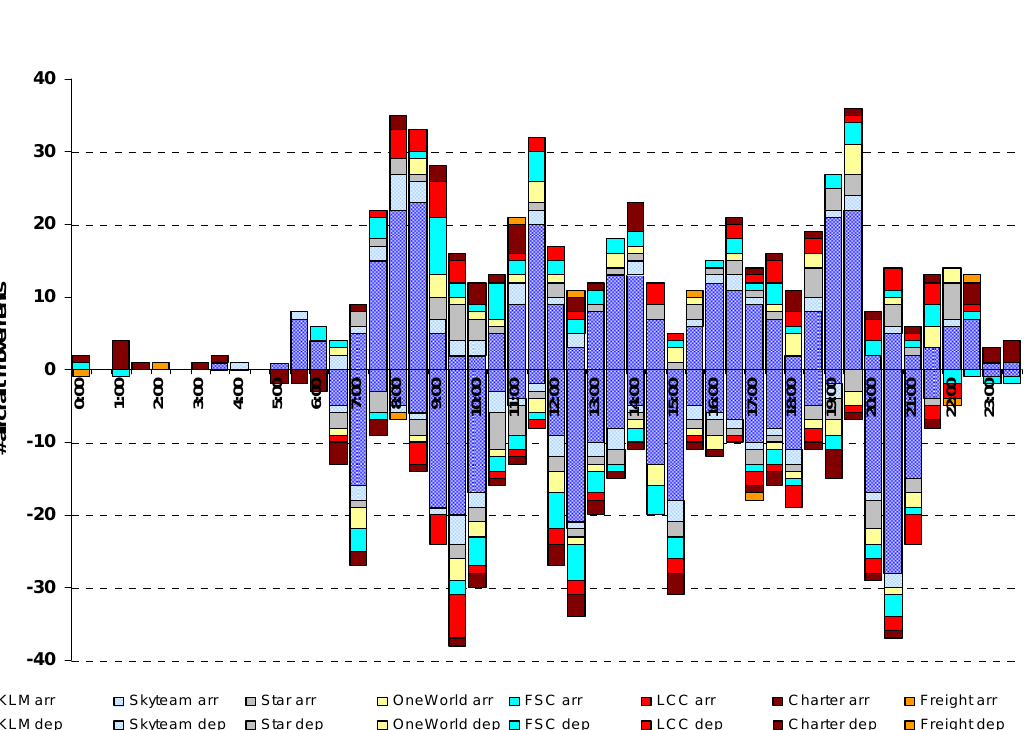
Figure 2. Total numbers of arrivals and departures per half hour and per traffic category at Amsterdam (OAG, 20-09-2006, local time) Source: OAG